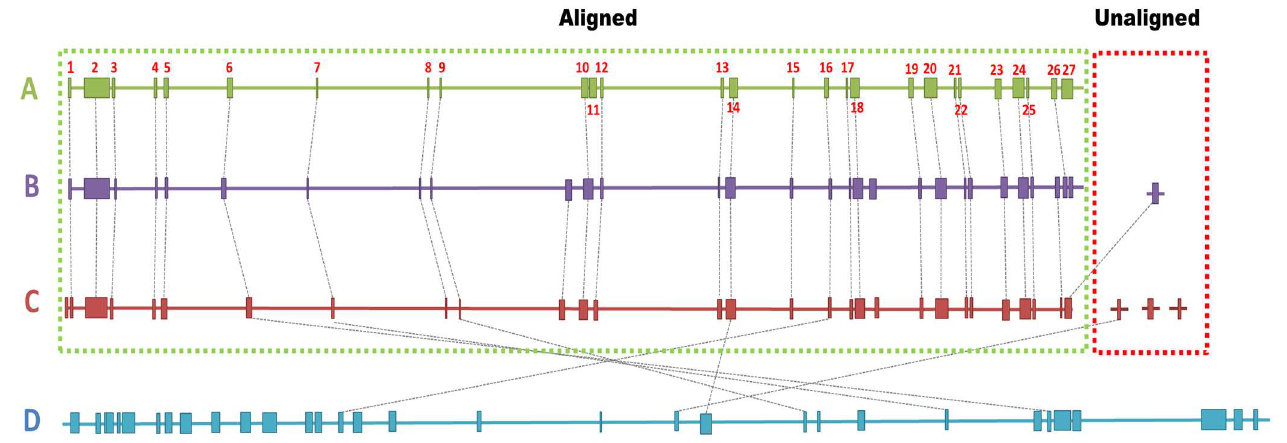
Figure 7. ( a ) Proteome similarity analysis carried out by the proteome comparison tool on PATRIC between—as ordered from the outside to the inside— S. vinaceusdrappus strain AC-40 as a reference, S. vinaceusdrappus strain JCM 4529, S. plicatus strain JCM 4504, and S. rochei strain 7434AN4; ( b ) A Venn diagram indicated the shared orthologous protein clusters among A ( S .vinaceusdrappus strain AC-40), B ( S. vinaceusdrappus strain JCM 4529), C ( S. plicatus strain JCM 4504), and D ( S. rochei strain 7434AN4).